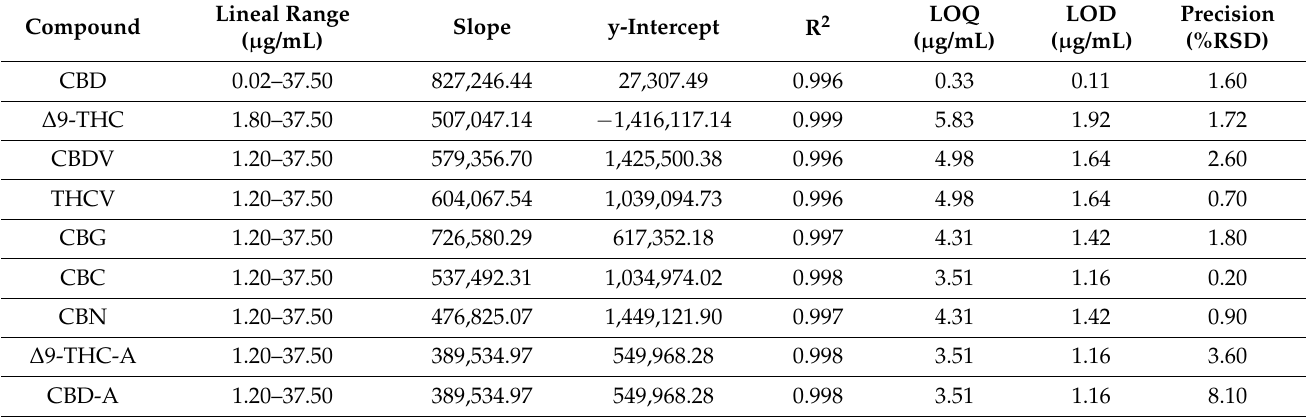
Table 1. Method validation parameters.